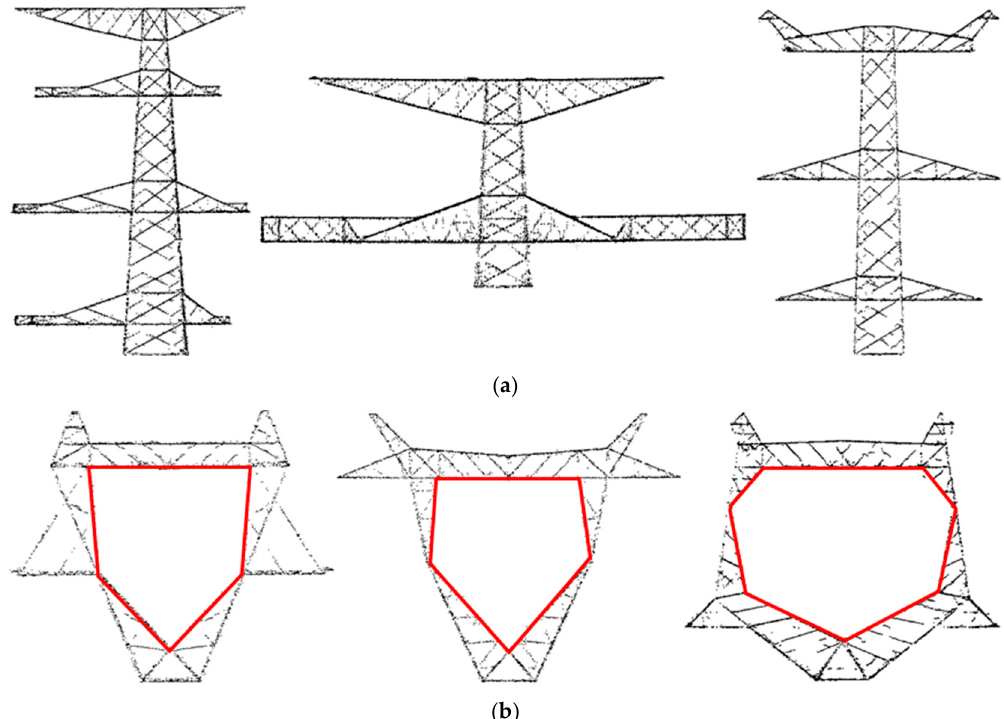
Figure 4. The type of complex structure: ( a ) Type-T structure; ( b ) Type-O structure.